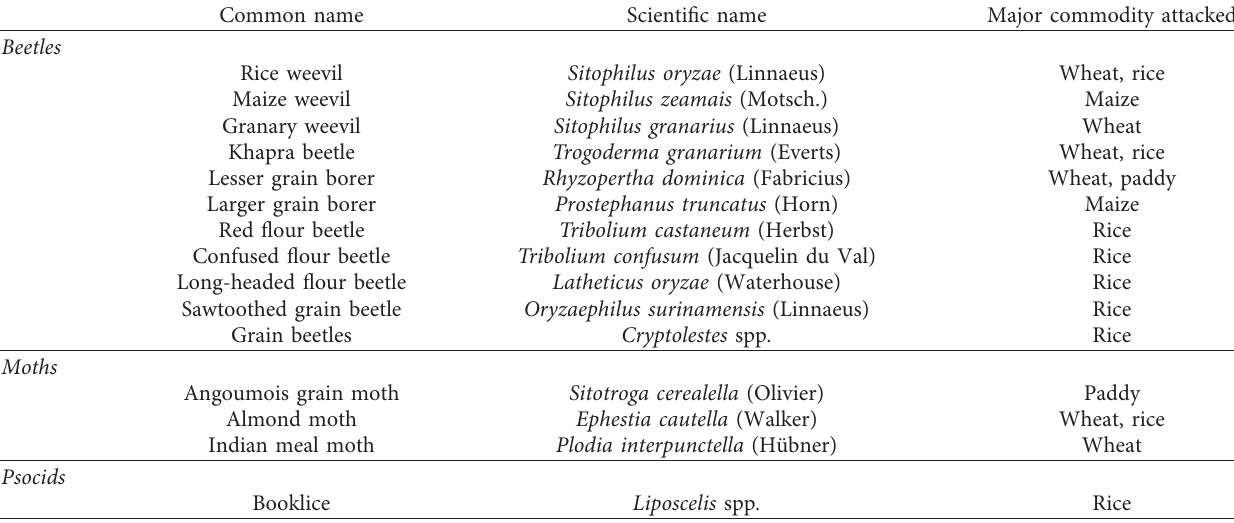
Table 1: Important stored grain insect pests in most African